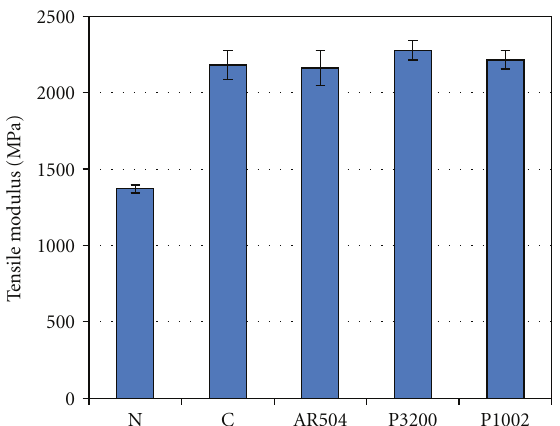
Figure 2: Comparison of the elastic tensile modulus of neat polypropylene to that of sunflower reinforced polypropylene blends with and without the inclusion of chemical compatibilizers.